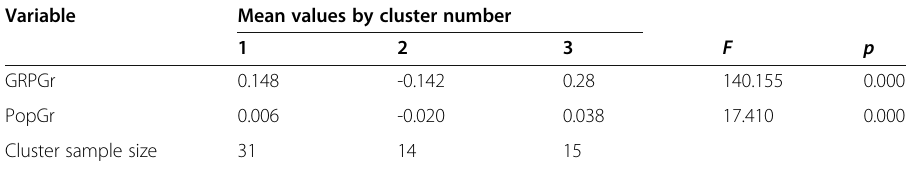
Table 2 Results of k -means cluster analysis